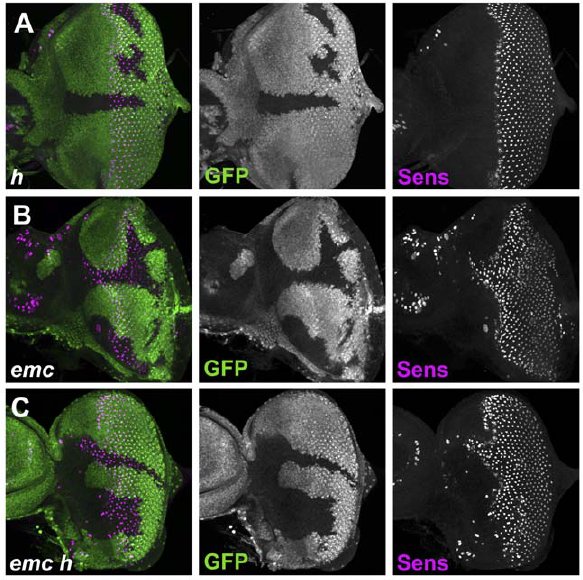
Figure 3. Morphogenetic furrow progression is regulated by emc not by hairy . Clones of homozygous mutant cells are labeled by the lack of GFP or LacZ expression (green). Sens labeling in magenta. (A) In h 22 mutant clones, differentiation remained unaffected. (B) In emc AP6 mutant clones, differentiation was significantly advanced compared to neighboring tissue, more so in clones extending further in the anterior- posterior axis like the one nearer the top of the disc. (C) In emc AP6 h 22 double mutant clones, morphogenetic furrow progression was significantly advanced compared to neighboring tissue, more so in clones extending further in the anterior-posterior axis like the one nearer the top of the disc. Genotype : (A) ywhsF; h 22 FRT80/[ Ubi-GFP ] M (3)67 C FRT80; (B) ywhsF; emc AP6 FRT80/[ Ubi-GFP ] M (3)67 C FRT80; (C)